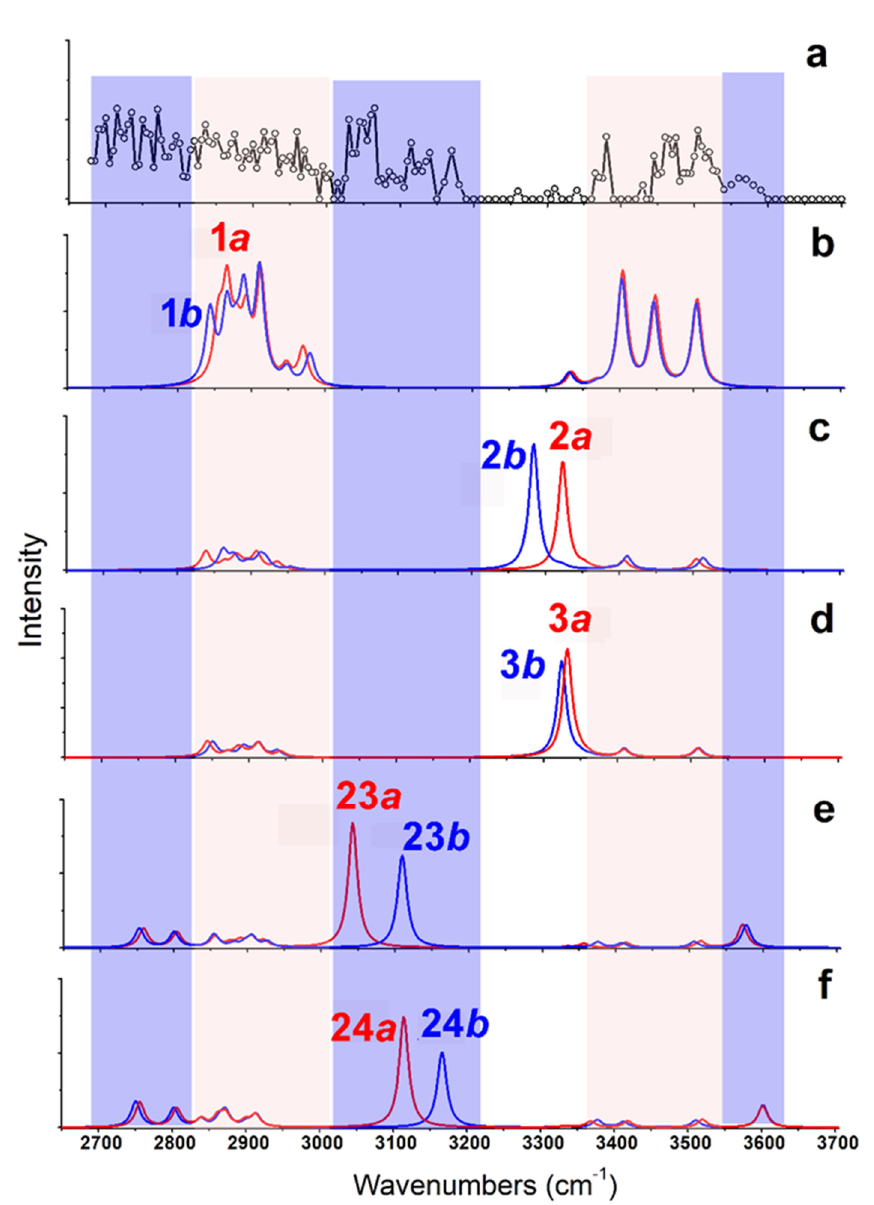
Figure 4. ( a ) Experimental IRMPD spectrum of [Arg+Rb+K−H] + and ( b – f ) the calculated vibrational spectra of different isomers obtained at the level of B3LYP/6-311++G(d,p)~LAN. The structures of these isomers are shown in Figure 3.